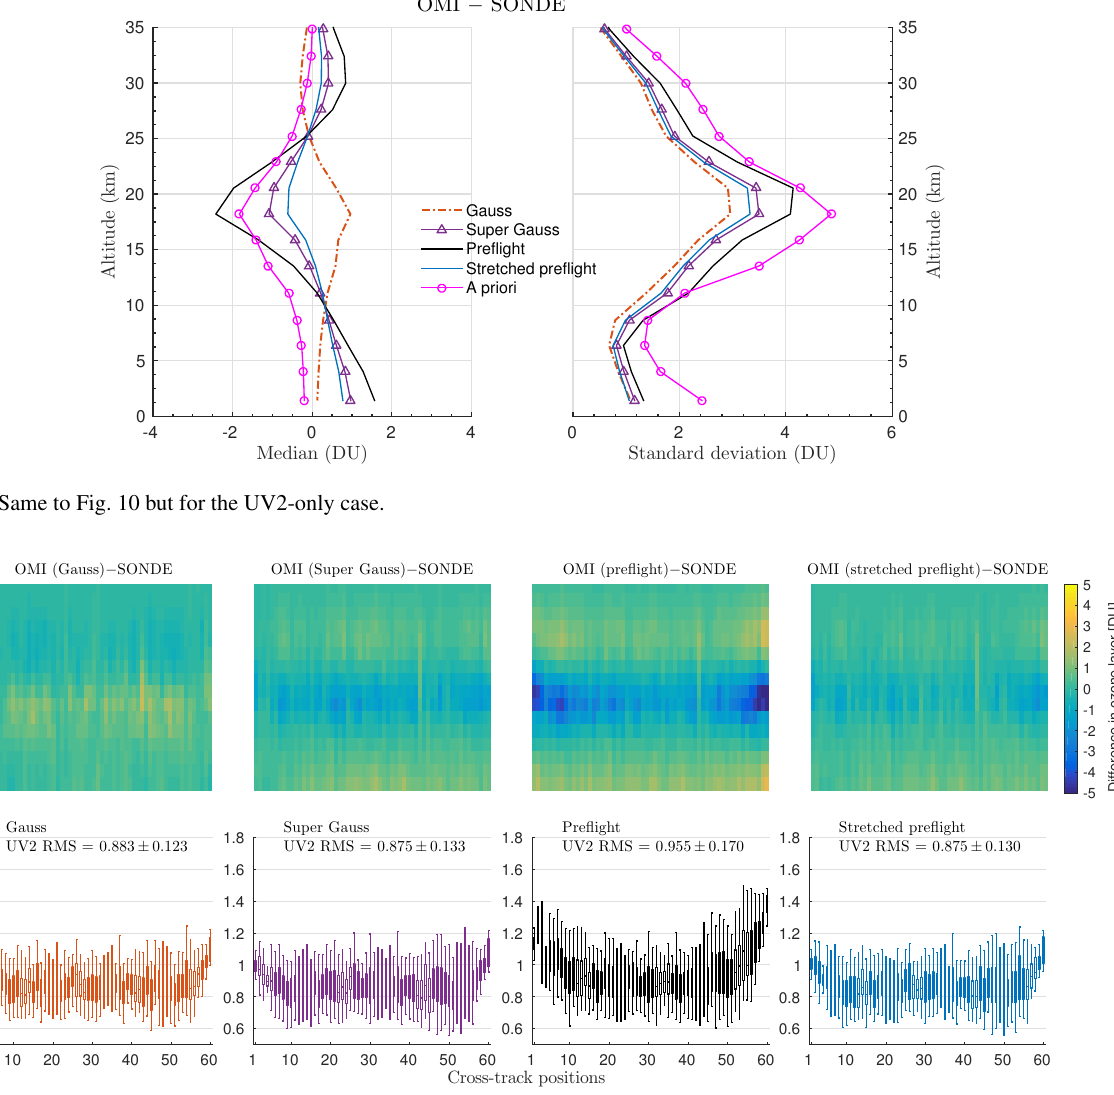
Figure 14. Similar to Fig.11 but for the UV2 band only. Note there are 60 rather than 30 cross-track